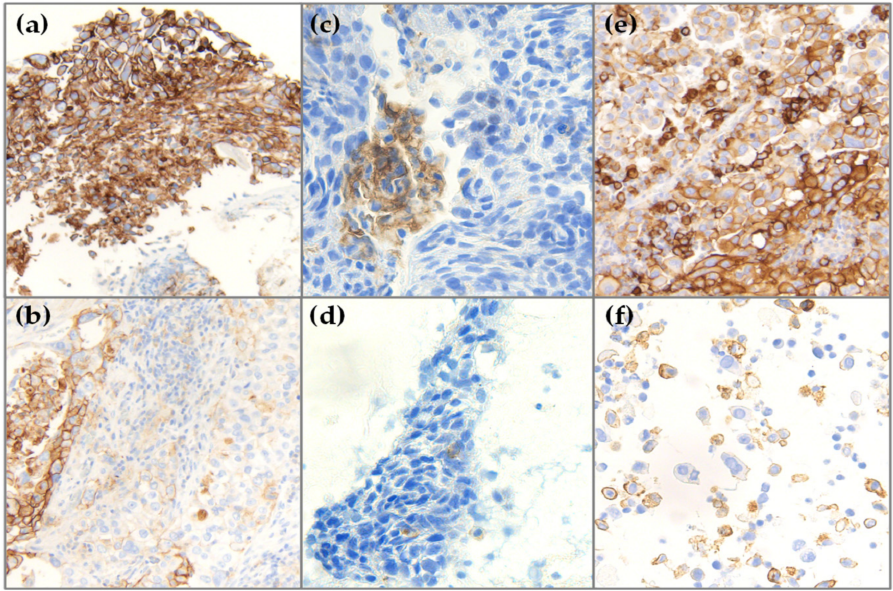
Figure 3. Representative images of three cases with more than one sample tested for PD-L1 ex- pression. Case 1, ( a ) endobronchial biopsy sample of a primary lung adenocarcinoma with PD- L1 TPS 100% (10 × magnification) and ( b ) surgical specimen with PD-L1 TPS 40% (10 × magni- fication). Case 2, ( c ) endobronchial biopsy of a squamous cell carcinoma with PD-L1 TPS 5% (20 × magnification) and ( d ) cytological block from a lymph node metastasis with PD-L1 TPS of <1% (20 × magnification). Case 3, ( e ) surgical specimen of a pleomorphic carcinoma showing PD-L1 TPS 90% (10 × magnification) and ( f ) paired cytological block from a carcinoma in the lung with PD-L1 TPS 70% (20 × magnification). Abbreviations: PD-L1, programmed cell death ligand 1;